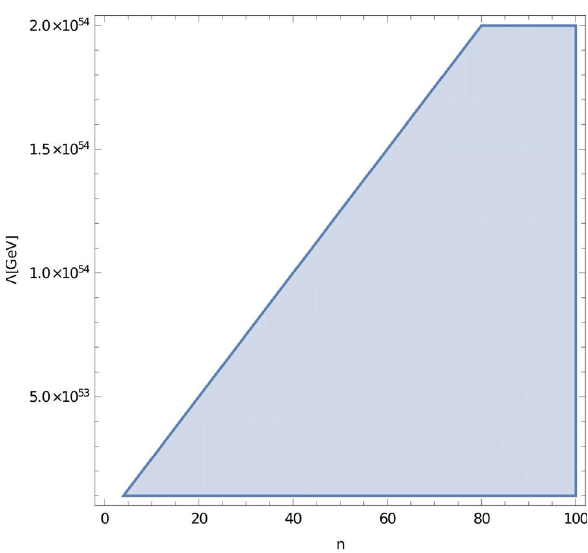
Fig. 2 Excluded parameter space ((cid:14), n ) from DAMA experiment, fix- ing m =